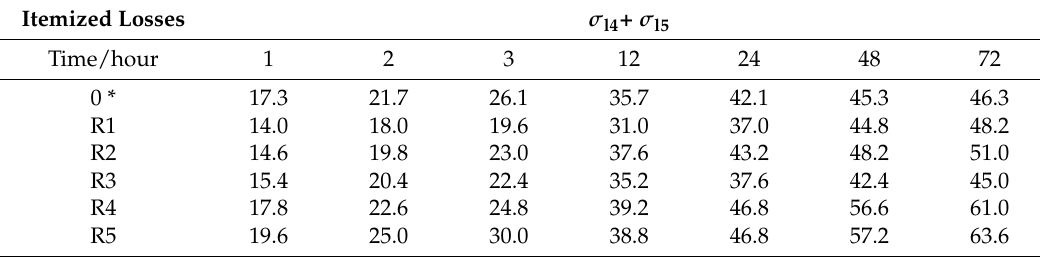
Table 10. The sum of σ l4 and σ l5 calculated from the strains obtained from the LFBG sensors. (Unit: MPa). Itemized